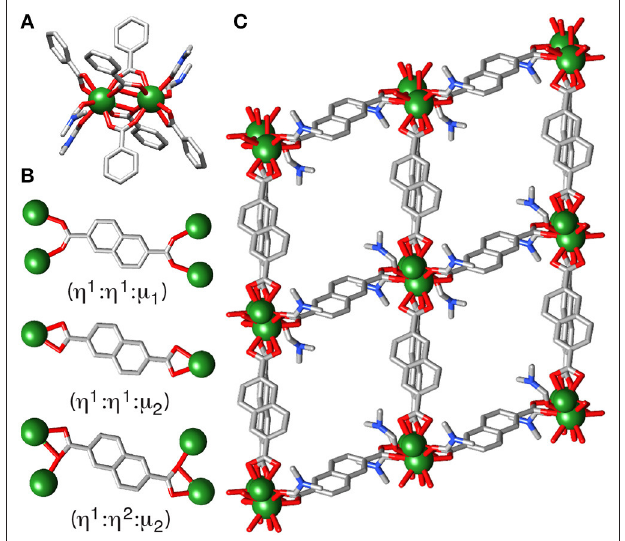
FIGURE 3 | The crystal structure of 3 . (A) The dimeric SBU. (B) The differing coordination modes of the crystallographically independent NDC 2 − ligands. (C) The packing structure viewed down the a axis. H atoms removed for